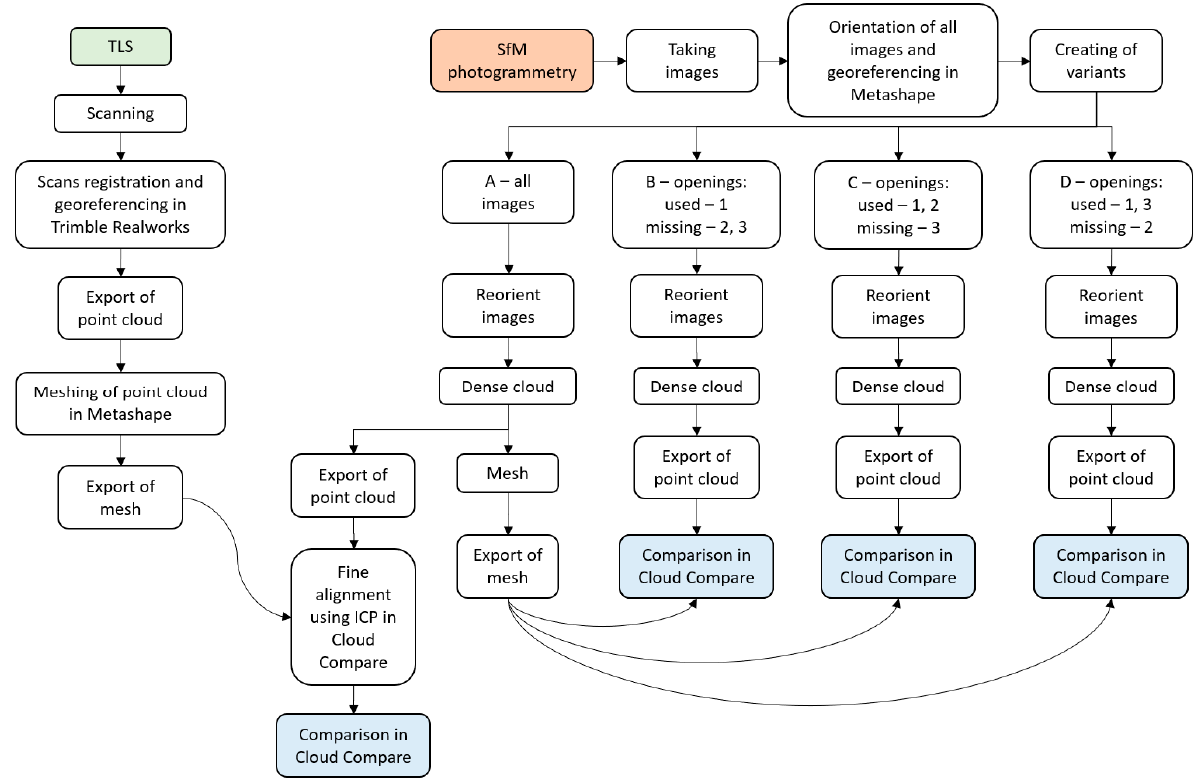
Figure 6. Opening no. 3 ( left ), and the positions of the cameras in the connecting image strip ( right ).